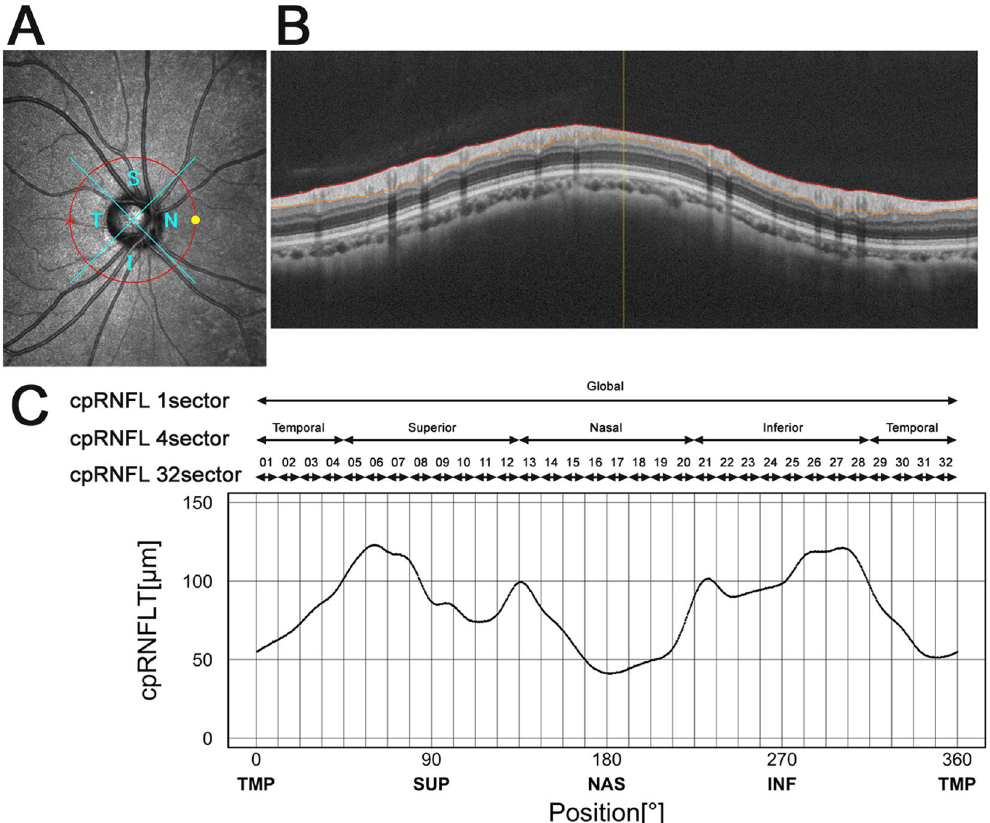
Figure 1. Illustration of the 32 sectors along the RS-3000 advanced (Nidek) optical coherence tomographic (OCT) circular image used for circumpapillary retinal nerve fibre layer thicknesses (cpRNFLT) analysis. ( A , B ) Circular B-scans 11.5° in diameter (3.45 mm in the Gullstrand’s eye) centred on the optic disc were obtained from the right eye of each participant. ( C ) cpRNFLT was measured at 1,024 points along the 360° OCT circle scan and divided into 4 or 32